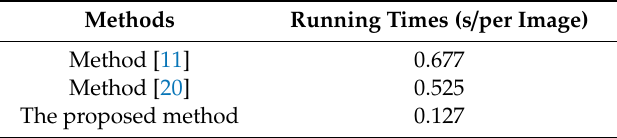
Table 6. The running times of the di ff erent methods.